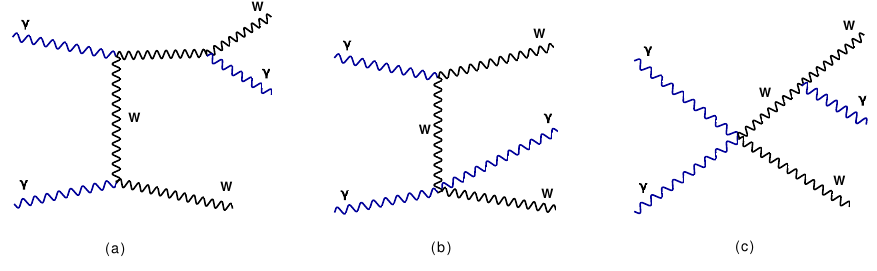
Figure 2 . Representative Feynman diagrams for (cid:13)(cid:13) ! W + W (cid:0) (cid:13) production at tree